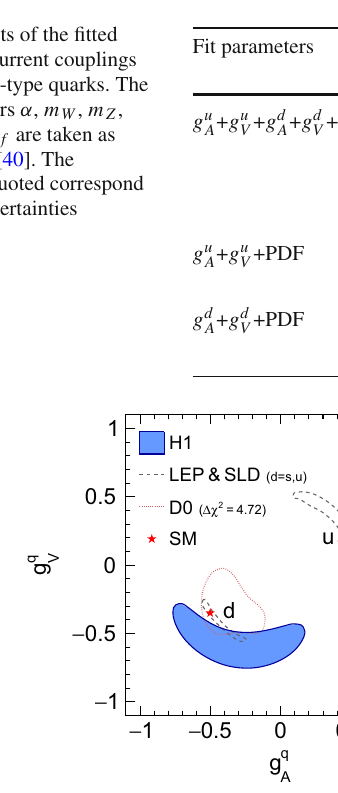
Fig. 4 Results for the weak neutral-current couplings of the u - and d -type quarks at the 68% confidence level (CL) obtained with the g u + g u + g d + g d +PDFfit.Theleftpanelshowsacomparisonwithresults A V A V from the D0, LEP and SLD experiments (the mirror solutions are not shown). The 68% CL contours of the H1 results correspond to